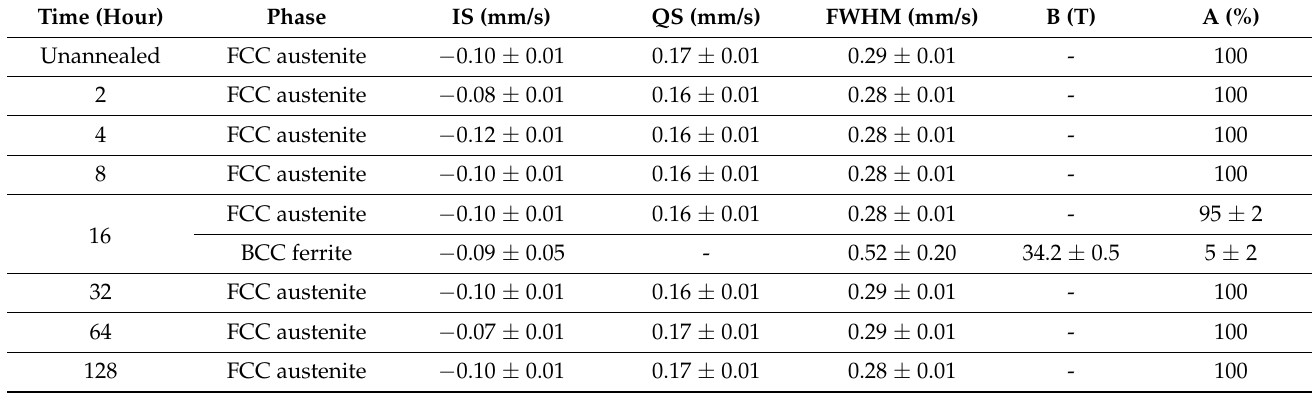
Figure 5. Conversion X-ray Mössbauer spectra of annealed samples.